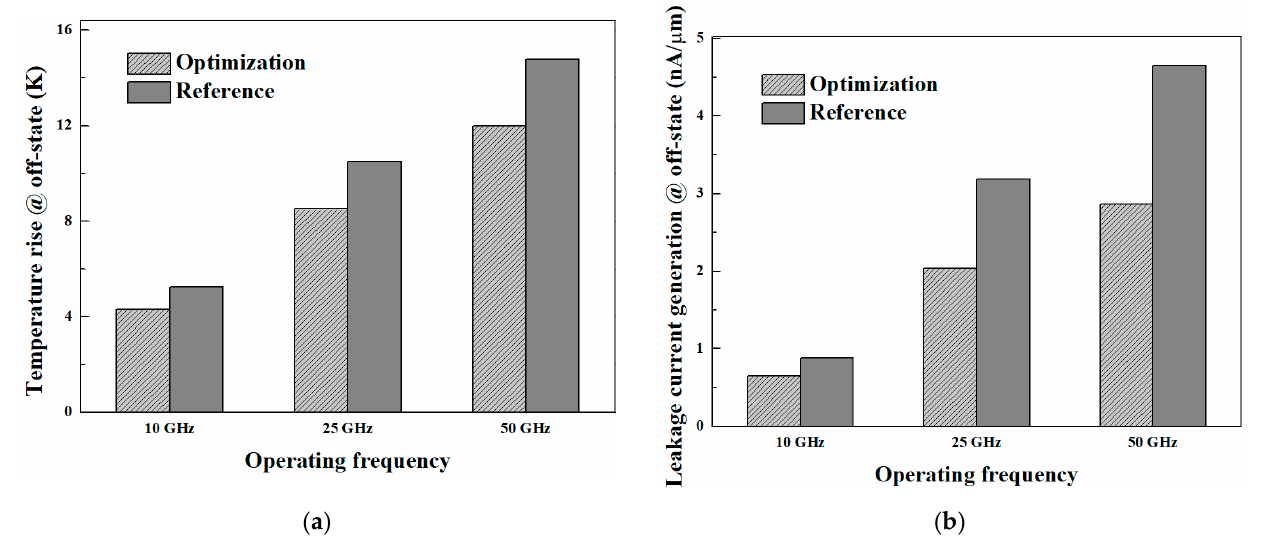
Figure 15. Comparison between: ( a ) the temperature rise by the SHE between the optimized and the reference structures; ( b ) corresponding leakage current generation at the off-phase of the pulse between the optimized and the reference structures.